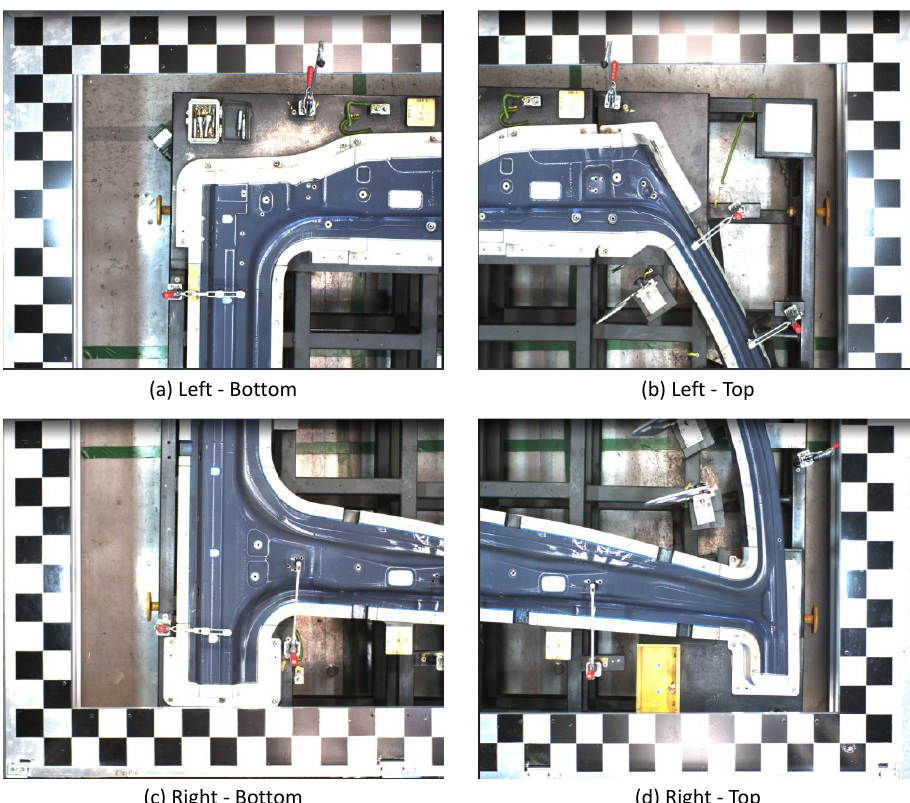
Figure 10. Image captured by RODIS.